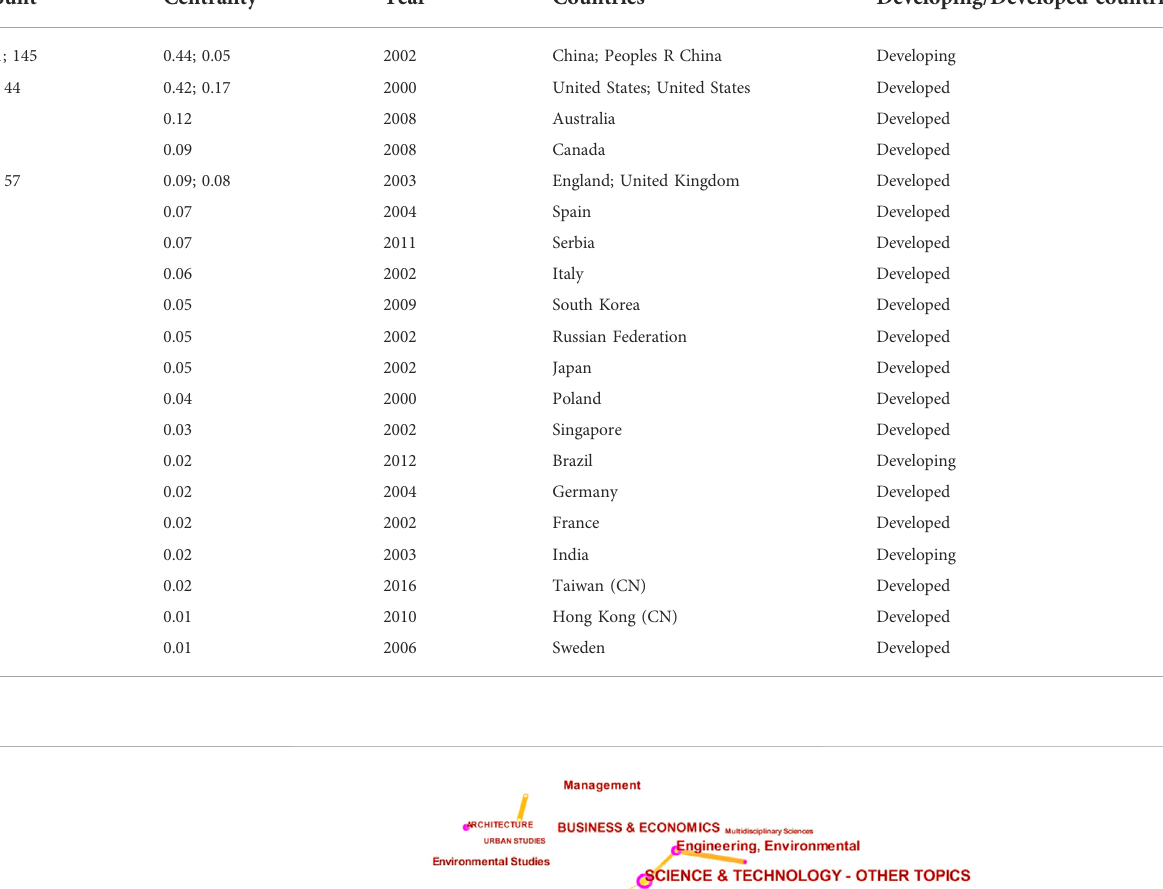
TABLE 3 Top centrality for countries of the research.